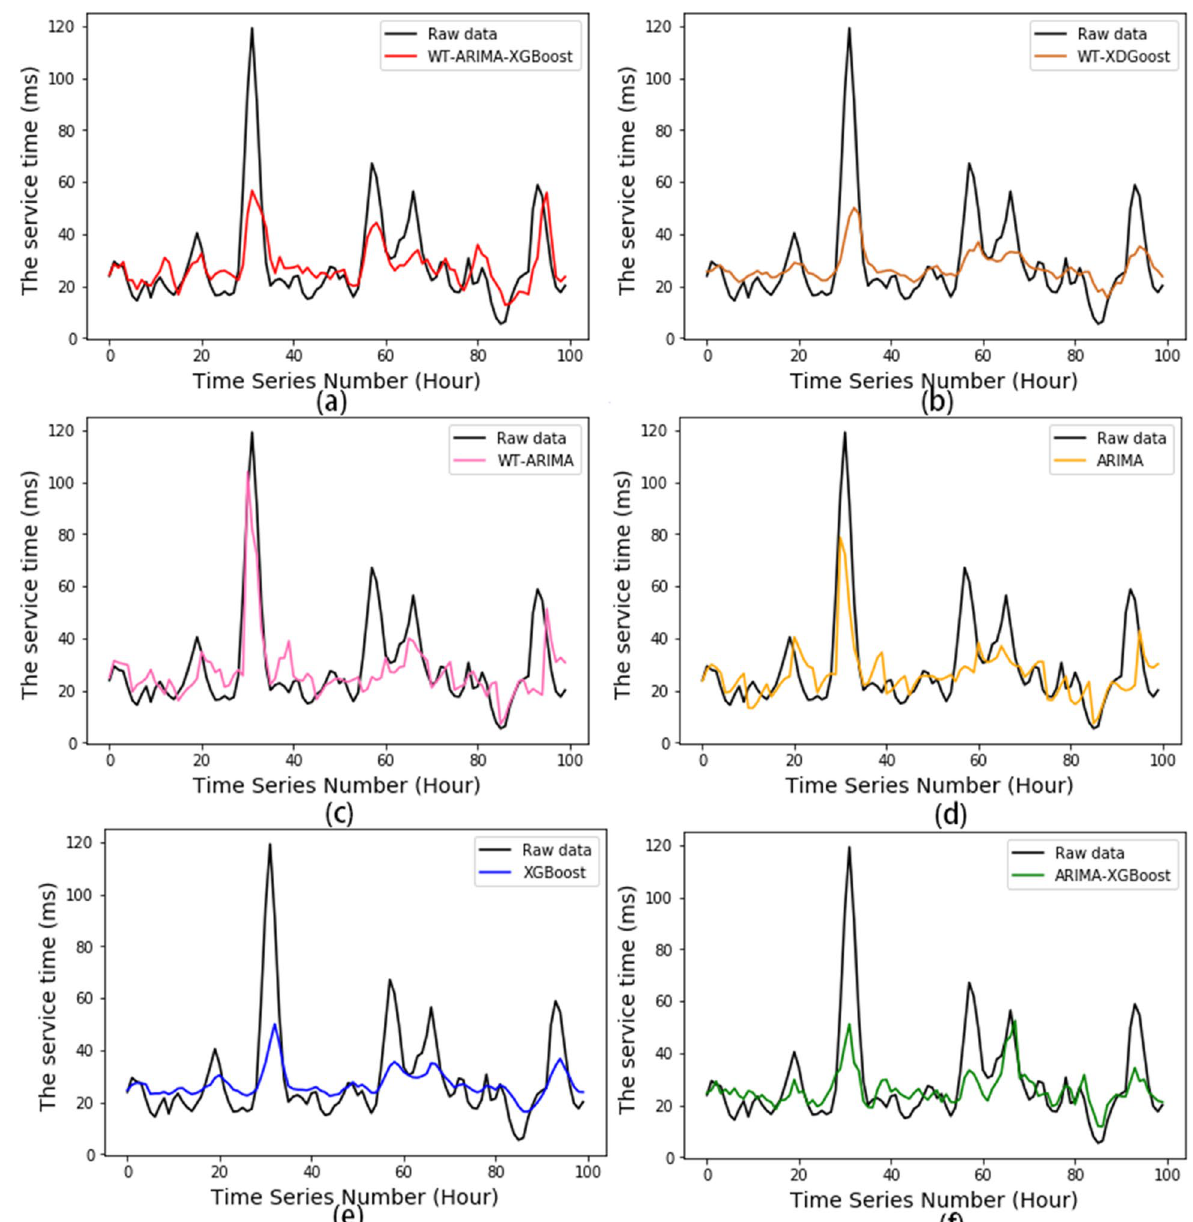
Fig. 7 Comparison of layer actions response time at five-step prediction using tested